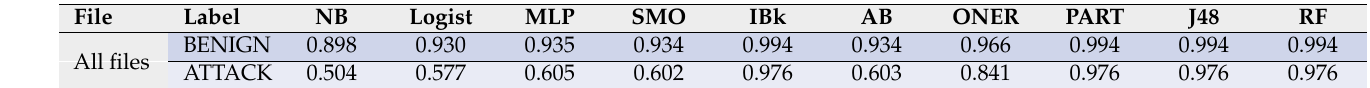
Table 17. F1 results in binary classification in complete dataset using attributes